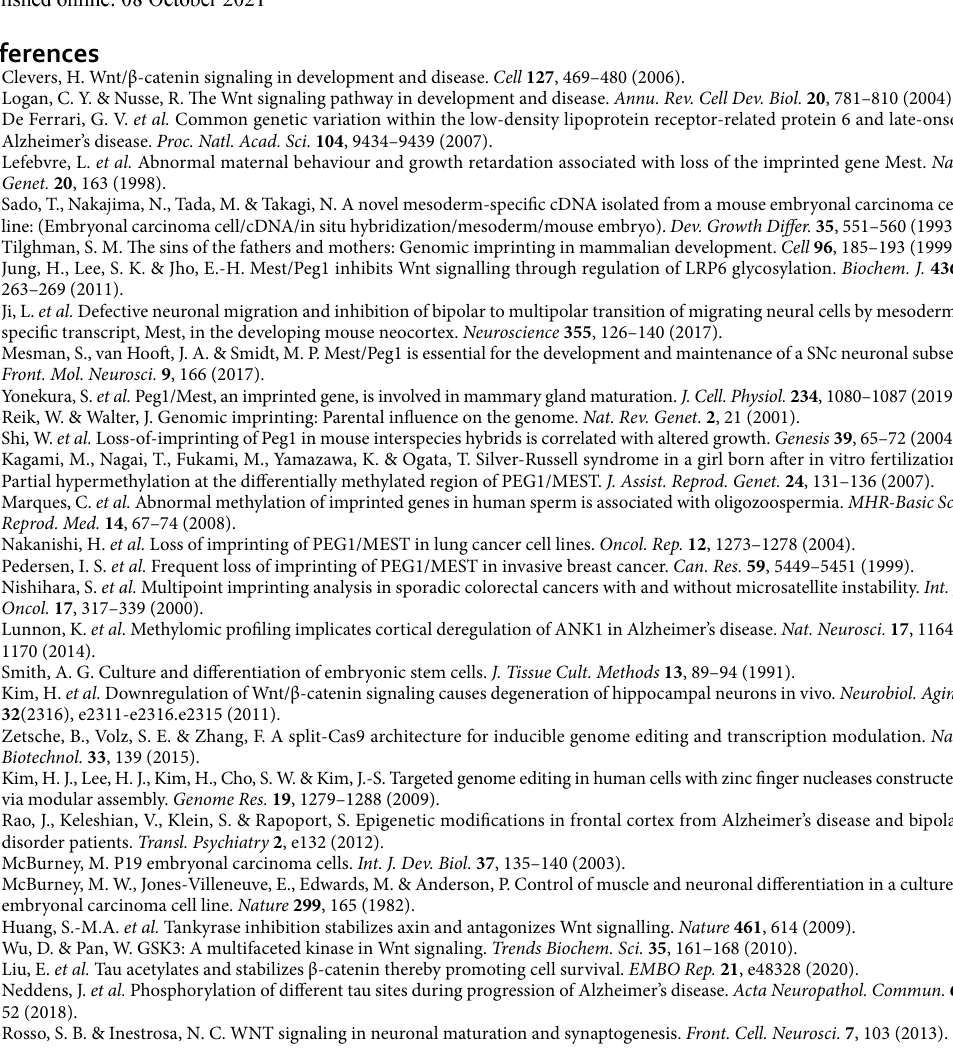
Figure 3. Mest depletion results in elevation of Wnt signaling and Tau phosphorylation, leading to neurodegeneration. ( a ) Relative mRNA expression of Mest, neuronal markers, and Wnt target genes in 11-day old neurons of P19 LSC-5 control and Mest gRNA stable cells treated with rapamycin. ( b ) Inducible knockout of Mest caused neurodegeneration in P19 Mest gRNA stable cells. P19 LSC-5 neurons treated with rapamycin were fixed and immunostained with anti-Tuj1 (green) and cleaved caspase-3 ((CC-3), (red)) antibodies. Phase contrast (top panels, scale bars, 100 μm) and fluorescent images (bottom panels) of 11-day neurons of P19 LSC-5 control and Mest gRNA stable cells induced with rapamycin. Scale bars, 88 μm. ( c ) Mest deficiency leads to increased Wnt signaling. Western blotting for Mest and the Wnt signaling components: LRP6, p-LRP6, β-catenin, and Active form of β catenin (ABC), in P19 Mest inducible KO cells isolated from (B) was performed. Vinculin was used as a loading control. Filled arrow indicates specific band. ( d ) qPCR analysis of Mest, neuronal markers, and Wnt target genes was performed with the same RNA samples harvested from hippocampal neurons infected with lentiviral shMest at DIV7 and incubated for 24 h. ( e ) Mest knockdown caused neurodegeneration in hippocampal neurons. DIV7 hippocampal neurons treated with lenti-shMest were immunostained with anti-Tuj1 (green) and cleaved caspase-3 ((CC-3), (red)) antibodies. Scale bars, 18 μm. ( f ) DIV7 rat hippocampal neurons treated with shMest lentivirus showed increased tau phosphorylation at S199 and Thr231 sites. All mRNA levels were normalized to that of β-actin. Data are shown as mean ± SD; *, p < 0.05; **, p < 0.01; ***, p < 0.001; ****, p < 0.0001 compared with the corresponding control group. Student’s t test was used for statistical